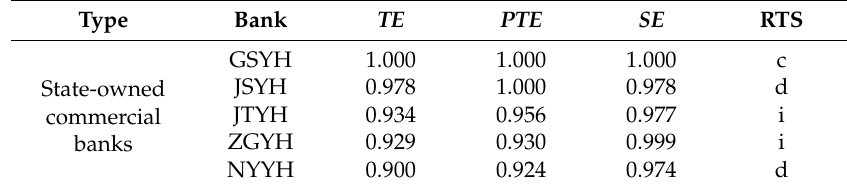
Table 5. The efficiency evaluation 1 of the state-owned banks in 2017.